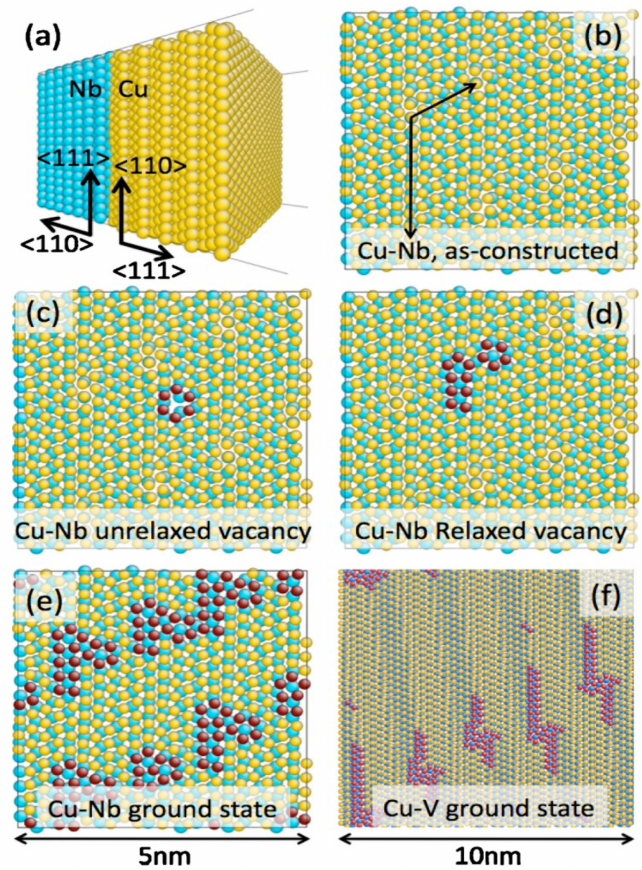
Figure 1. ( a ) Cu-Nb bilayer; ( b ) quasiperiodic pattern formed by the interface between Cu and Nb planes; ( c ) unrelaxed interface vacancy; ( d ) relaxed interface vacancy; ( e ) ground state Cu-Nb interface with 5 at % vacancies; ( f ) ground state Cu-V interface with about 0.8 at % vacancies. Dark red atoms that have less than six nearest neighbours in the interface Cu plane. Reproduced with permission from [20]. American Institute of Physics,